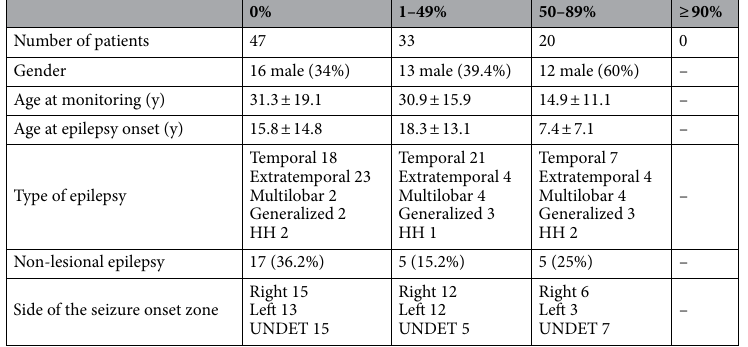
Table 2. Characteristics of patients according to the rate of eating related seizures. HH : hypothalamus hamartoma; UNDET : undetermined; y : years.